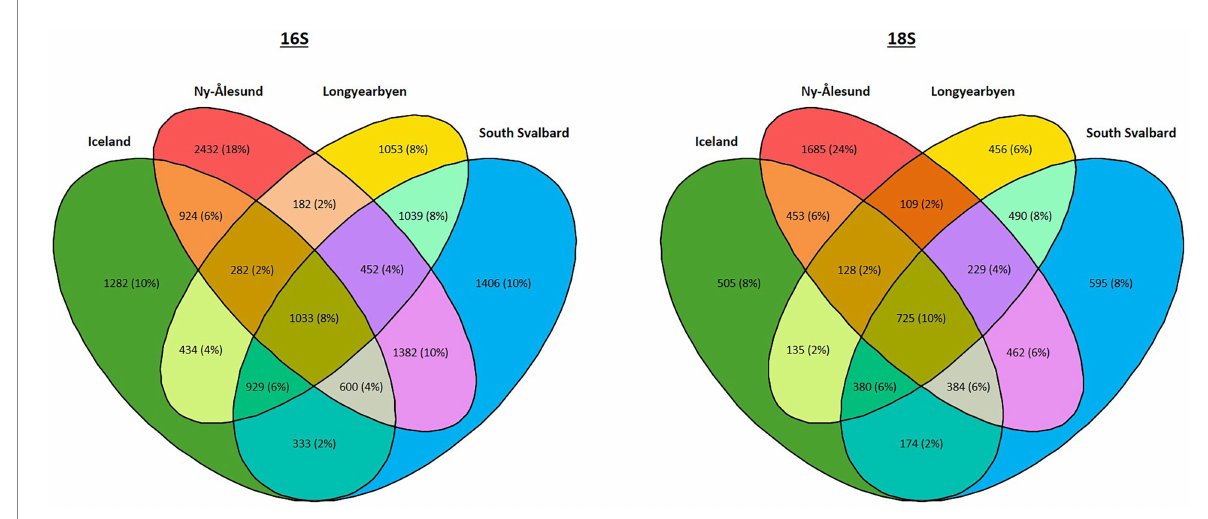
FIGURE 6 Venn diagram showing the number of common ASVs among the localities.